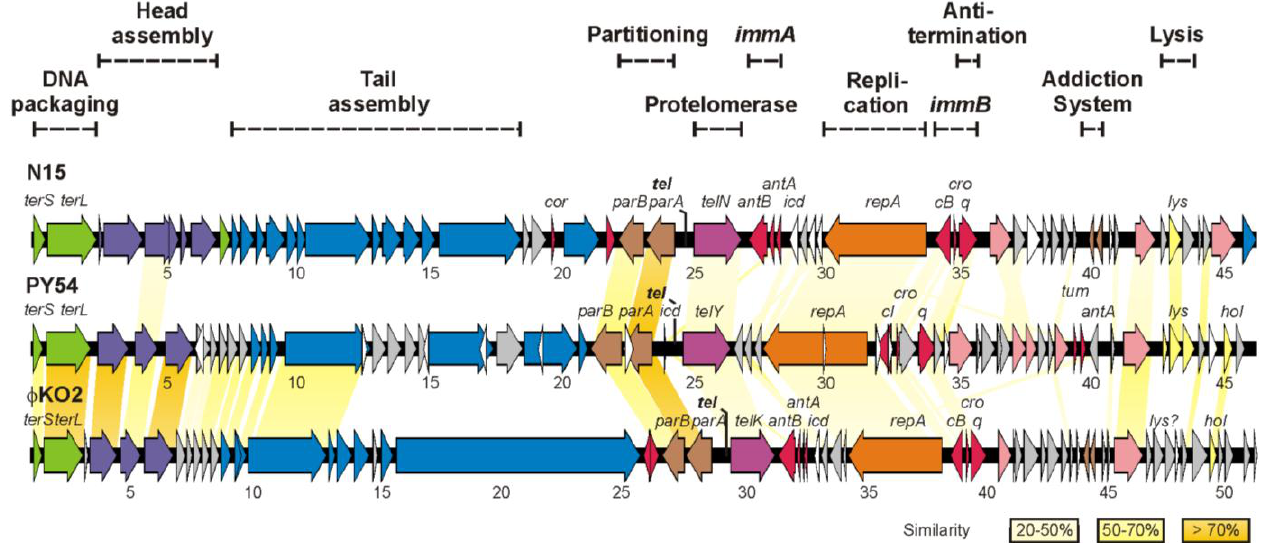
Figure 1. Genome organization of the phages N15, PY54 and φ KO2. Colors indicate the predicted functions of gene products. Related genes of the phages are connected by colored shading.